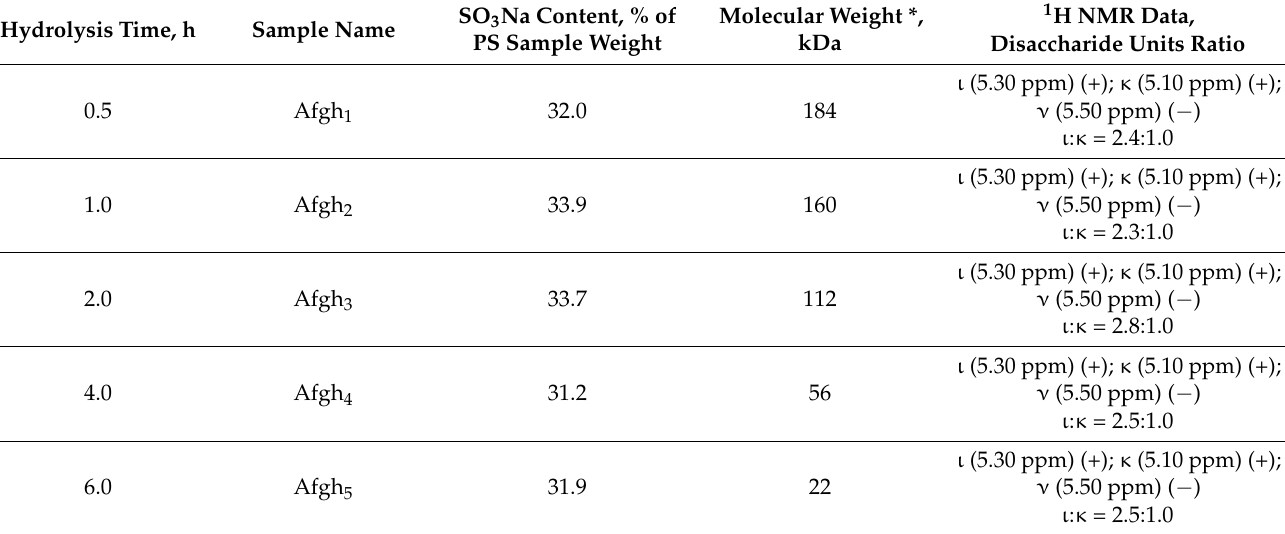
Table 3. Characterization of polysaccharides (PSs) with a lower molecular weight obtained by mild acid hydrolysis of Mp and Afg (0.1 N HCl, 37 ◦